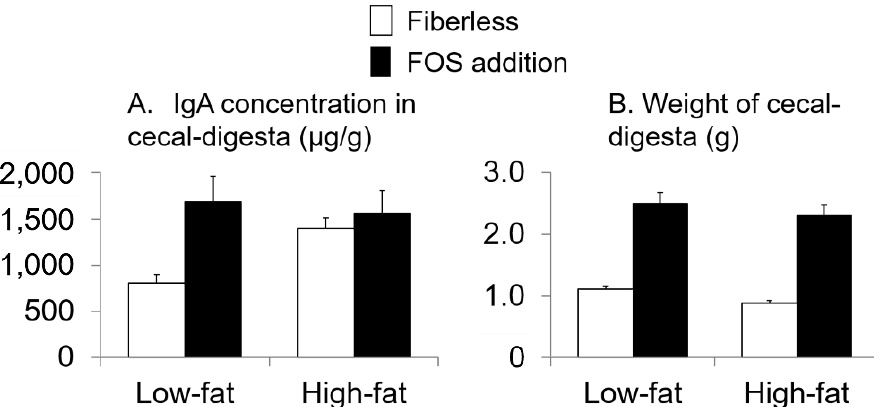
Figure 3. Effects of fat intake and fructo-oligosaccharide (FOS) supplementation on the immunoglobulin A (IgA) concentration in cecal-digesta ( A ) and weight of cecal-digesta ( B ). Values are Means ± SEM. n = 8 per group. two-way ANOVA.